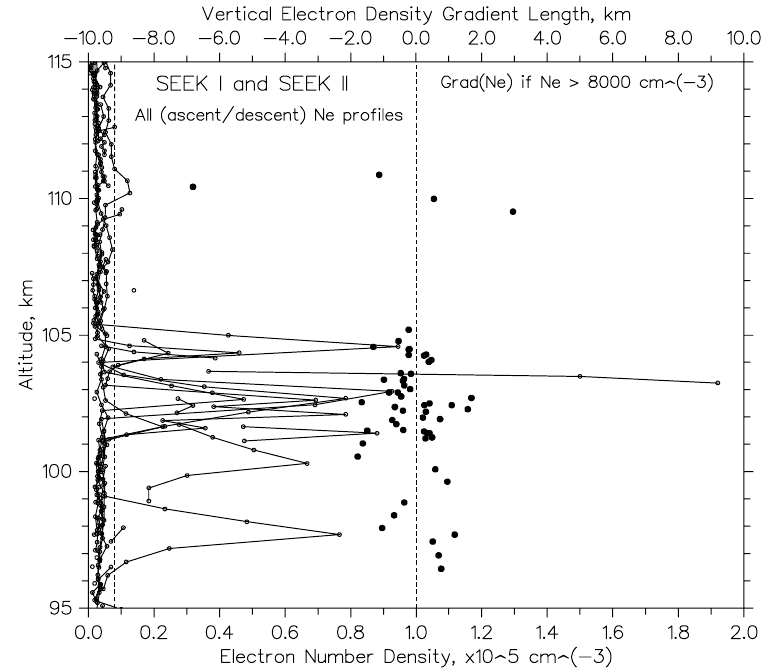
Fig. 3. Same as in Fig. 2, but now all eight, ascent and descent, SEEK I and II electron density profiles are superimposed. The dots denote the computed vertical plasma density scales inkm, shown only at the sporadic E-layer heights. The SEEK rockets were flown at times when the E layers were unstable to GD and FB plasma irregularities.